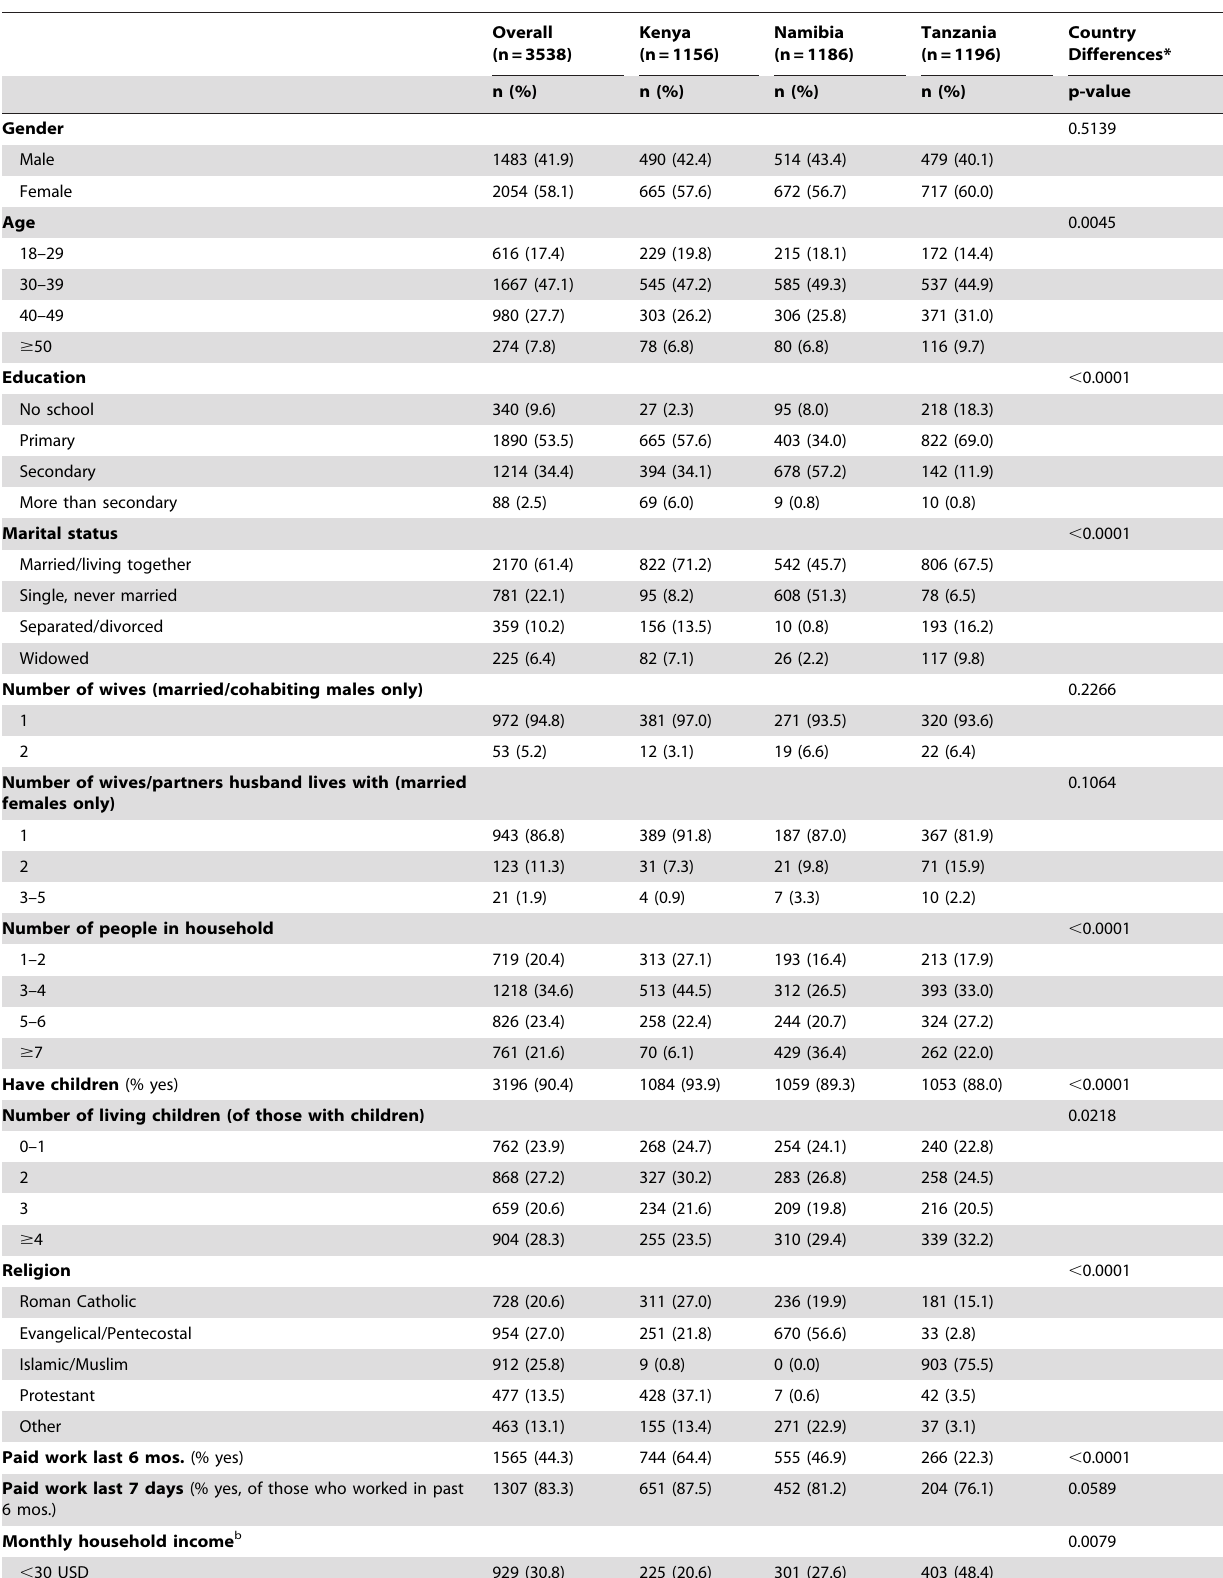
Table 1. Sociodemographic and health characteristics of baseline PwP evaluation study